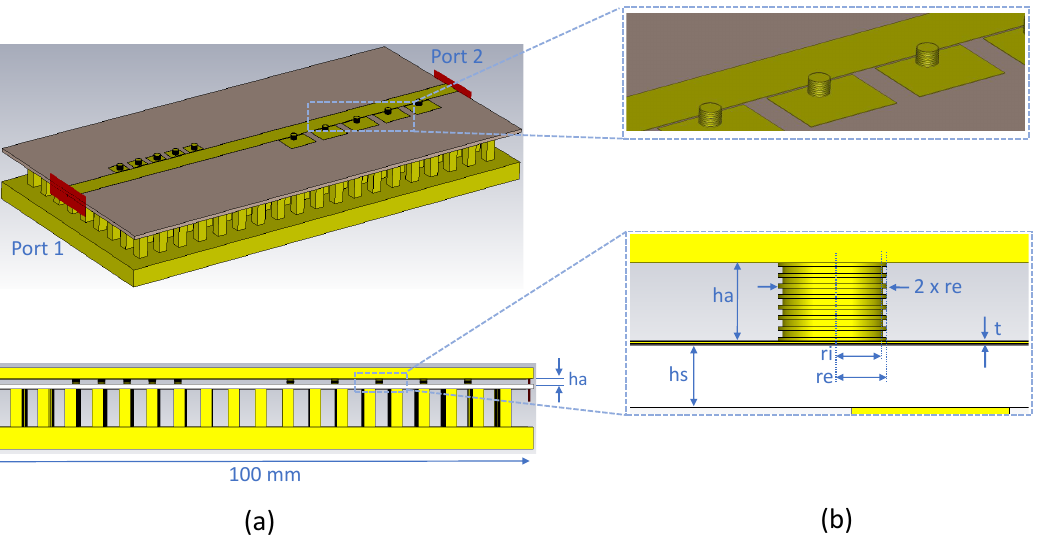
Figure 5. Three-dimensional geometry of EBG filter. ( a ) Perspective and side views. ( b ) Screw model